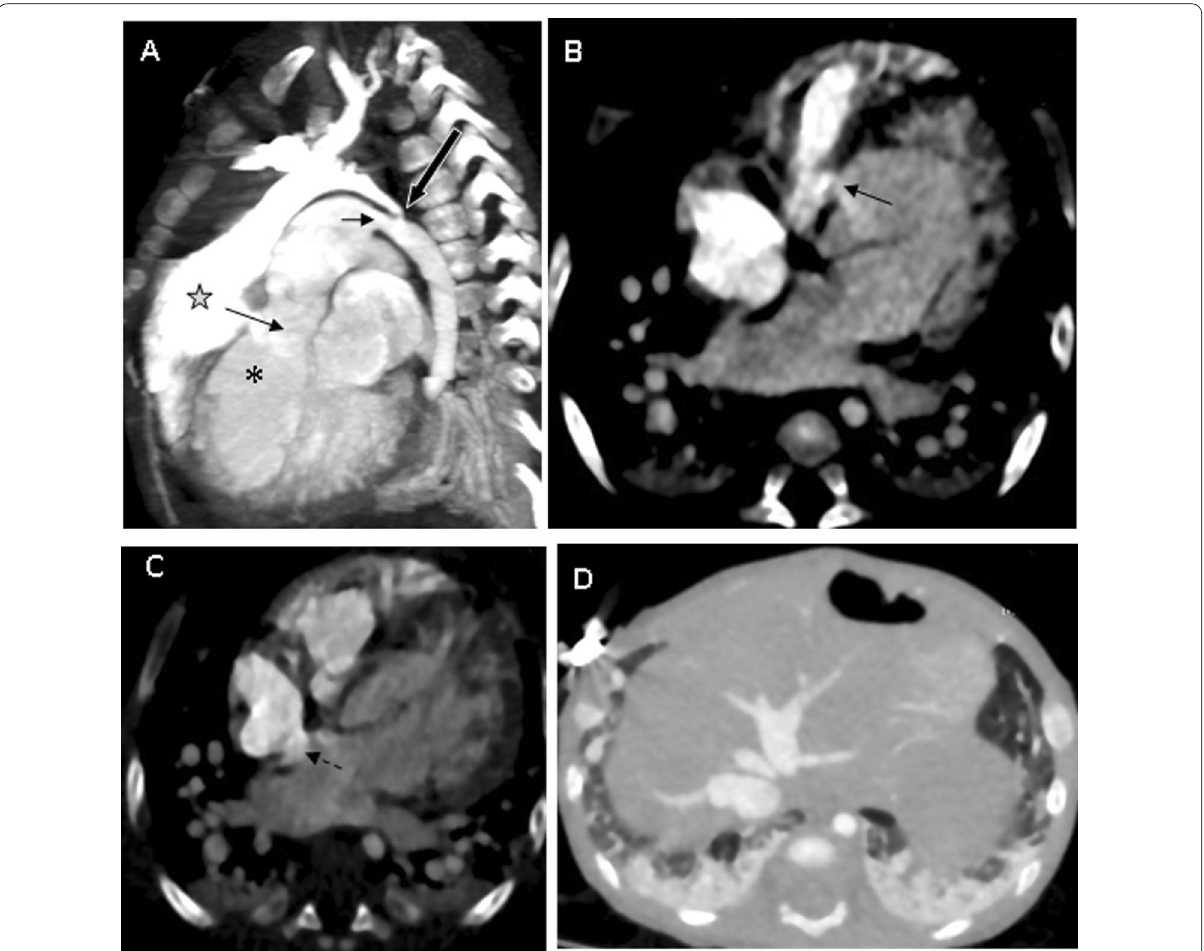
Fig. 6 A 2-month-old male with D-TGA. A Sagittal MIP showing aorta is anterior & to the right arising from morphologic RV(star), main pulmonary artery (MPA) is posterior & to the left, arising from morphologic LV(*), hypoplastic aortic arch with tight aortic Coarctation (block arrow), a large PDA seen continuing as a normal sized descending aorta (short arrow) with VSD (long arrow). B – D Axial images showing. B Small muscular VSD (arrow). C ASD (dashed arrow). D Patchy consolidation of both lower lung lobes, Congested IVC, hepatic veins and Congested